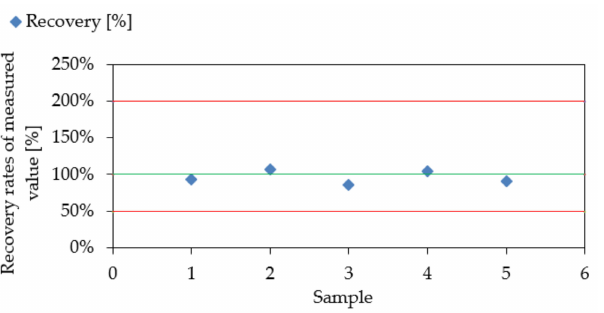
Figure 10. Recovery rates of measured values obtained during the second field trial, considering the relative difference between the measured concentrations in relation with the expected ones, obtained during the second field trial.